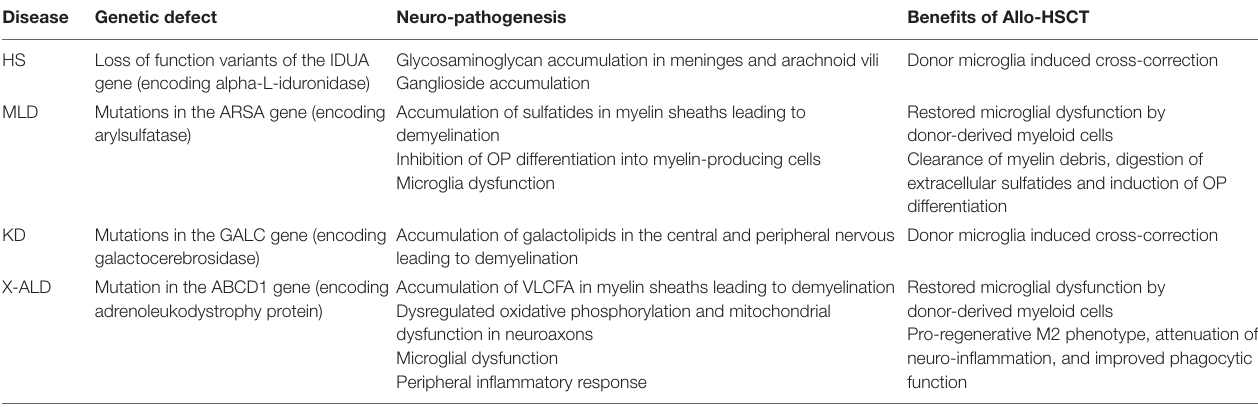
TABLE 2 | Summary of the genetic defects, neuro-pathogenesis and benefits of Allo-HSCT in IEM with neurological involvement. Disease Genetic defect